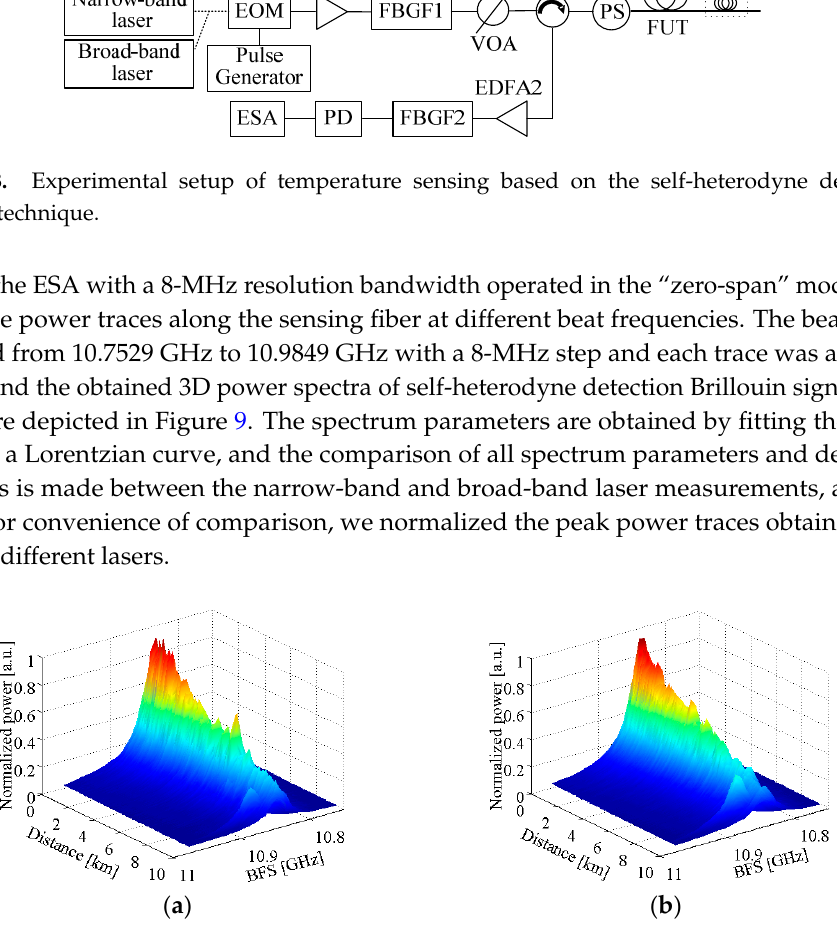
Figure 9. 3D power spectra of the self-heterodyne detection Brillouin signals with a ( a ) narrow-band laser and ( b ) broad-band laser. The temperature of the thermostatic water bath is set at 50 °C.